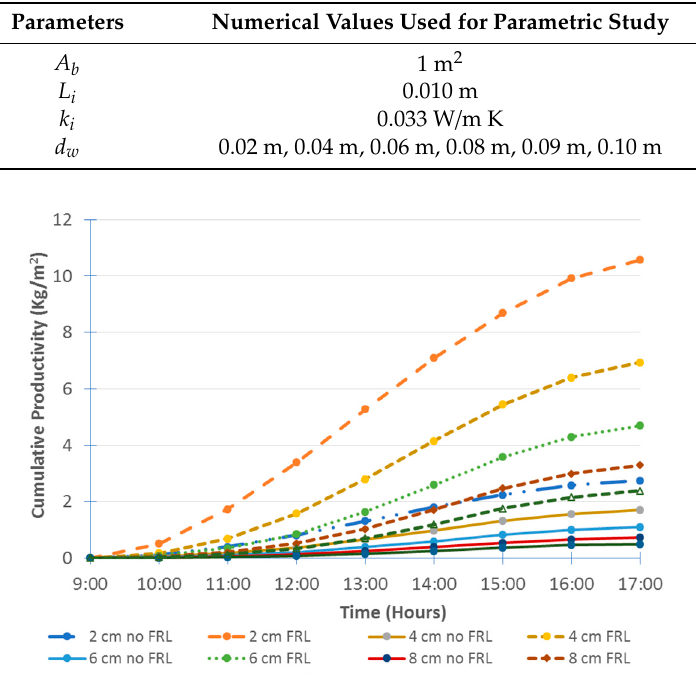
Figure 8. Hourly variation of cumulative water productivity with and without FRL for different depths.